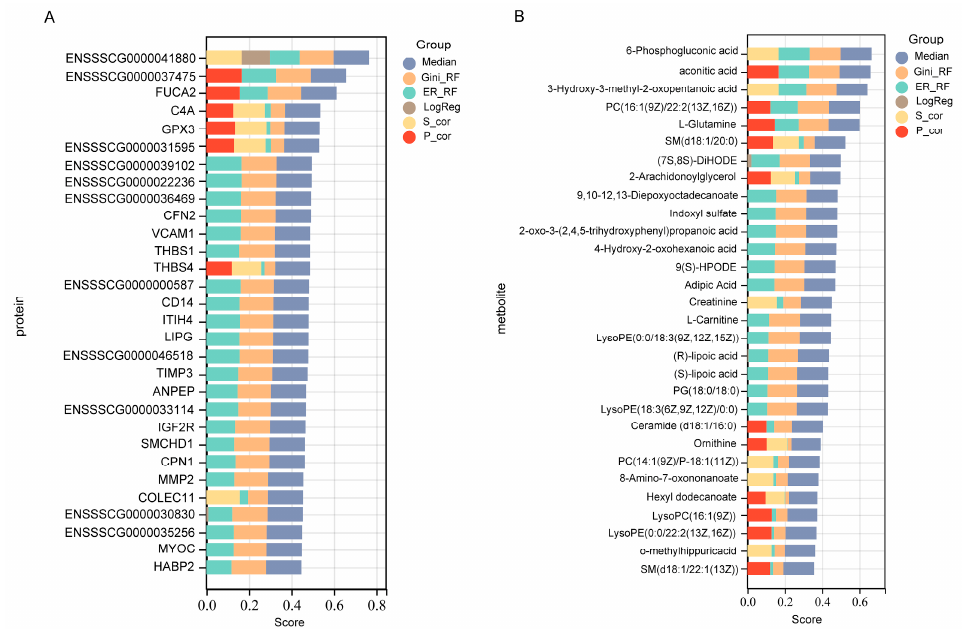
Figure 3 . Identification of high-confidence biomarkers for predicting adaptive immune differences between pig breeds. ( A ) Top 30 ensemble feature selection (EFS) proteins (LW versus M); ( B ) Top 30 EFS metabolites (LW versus M).